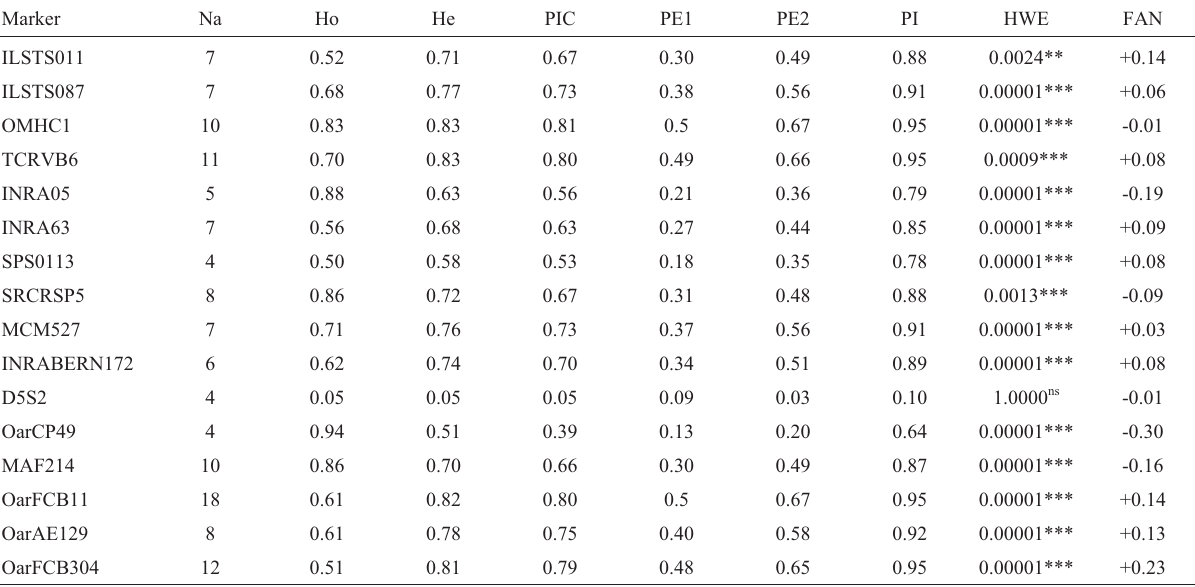
Table 2 - Combined genetic variability parameters for each microsatellite marker analysed in eight goats breeds.